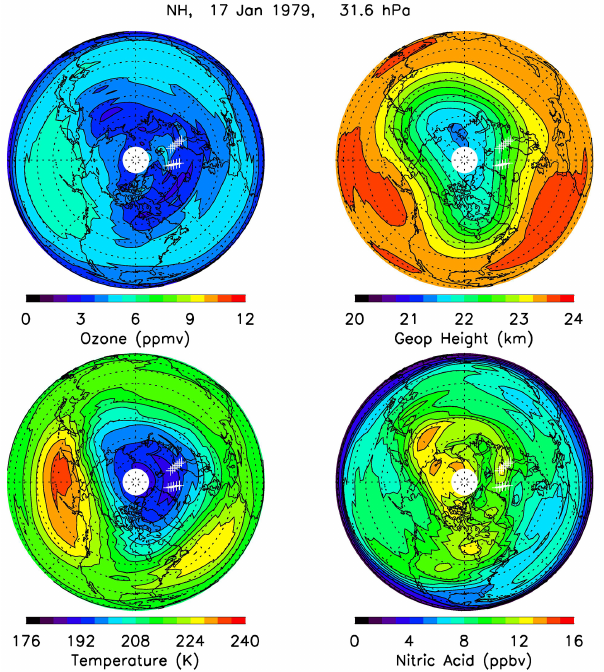
Figure 12. As in Fig. 2, but for 17 January.